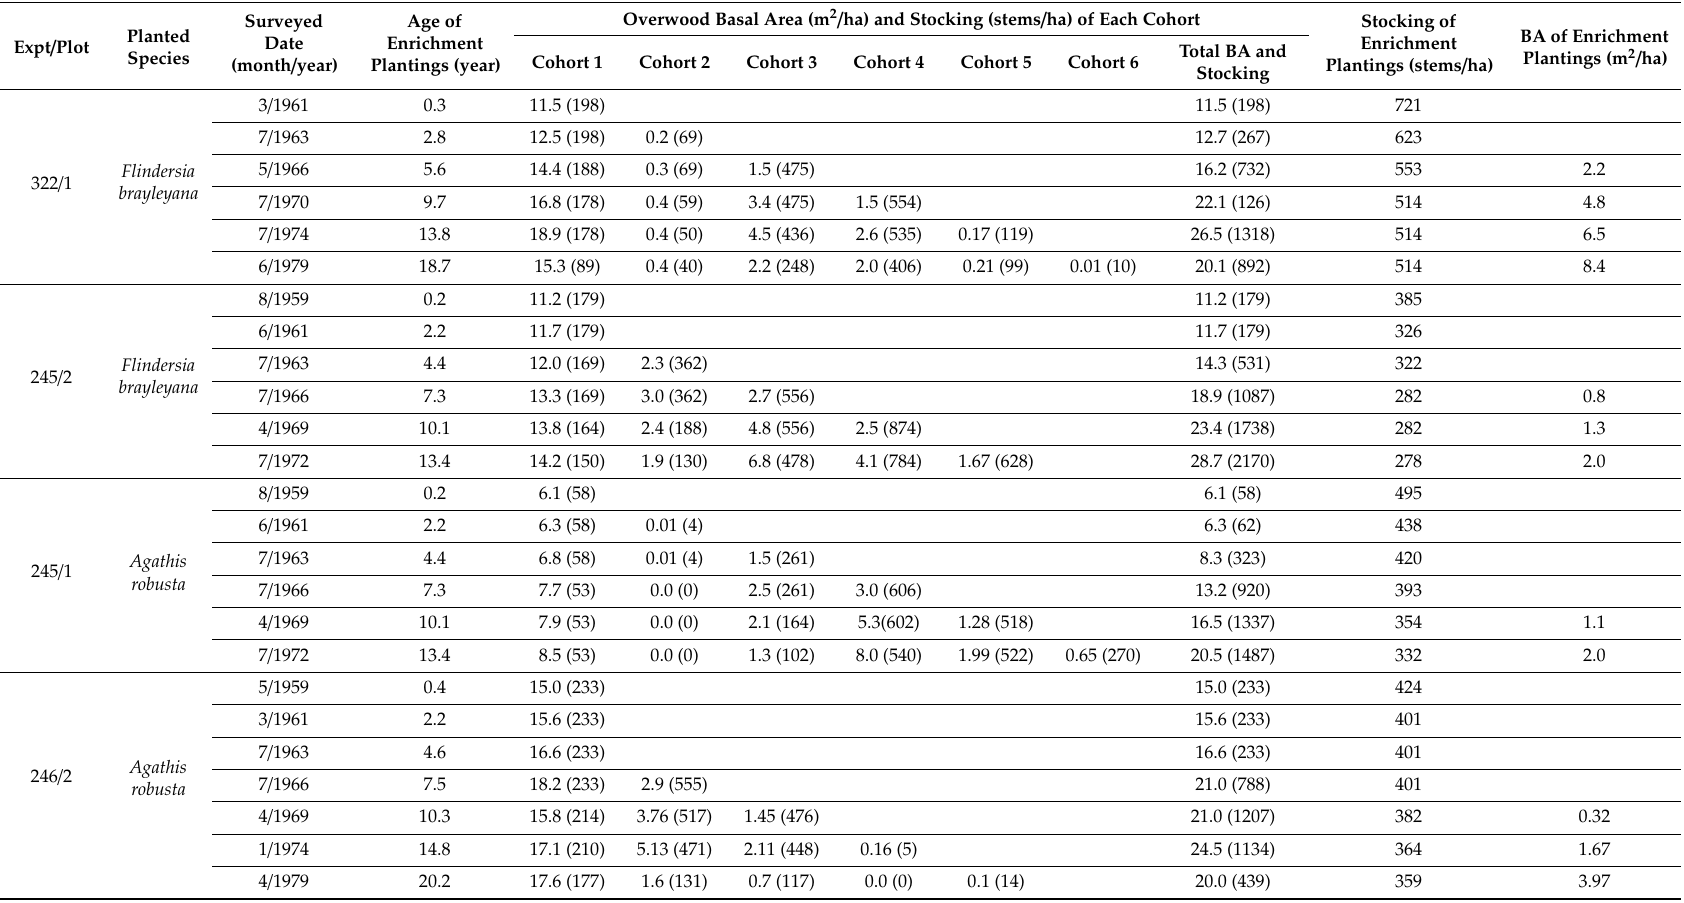
Table A5. The development of cohorts of overwood over time in enrichment planting experiments in north